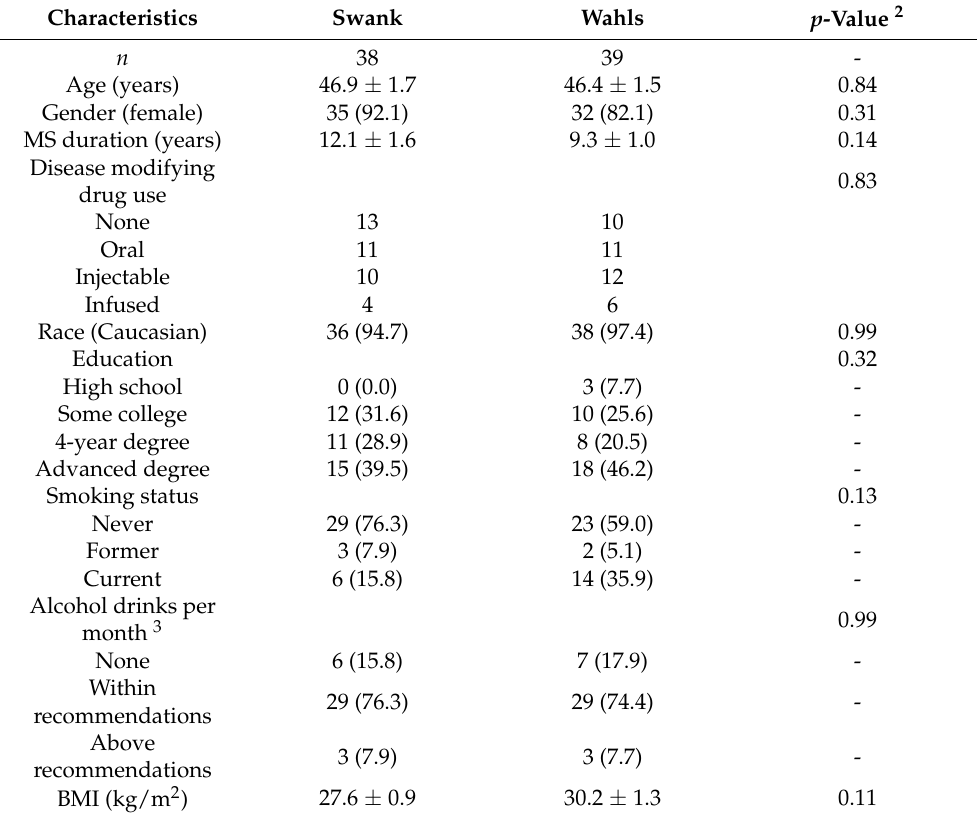
Table 1. Baseline characteristics of participants who completed a 12-week intervention of the Swank or Wahls diets 1